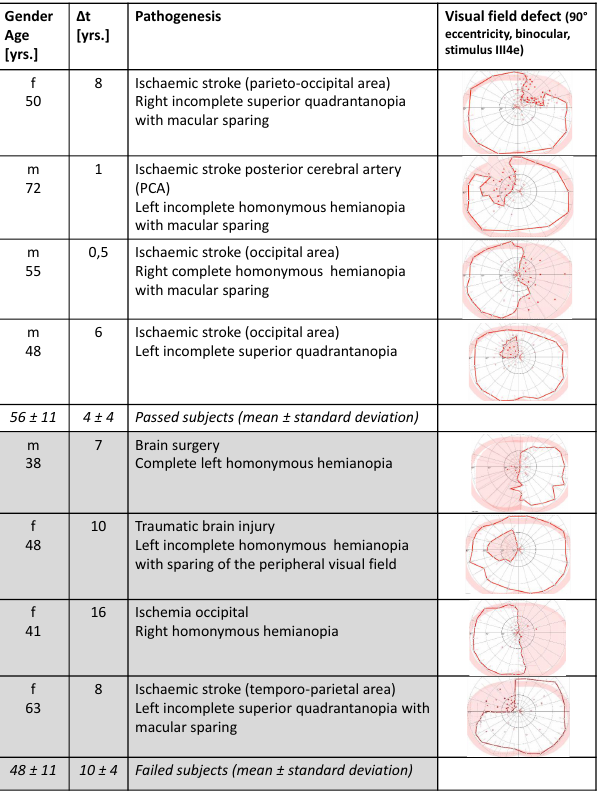
Figure 1 . Demographic data and binocular visual fields for the HVFD patients. ∆ t denotes the time since brain lesion. Patients who failed the driving fitness test are shaded in gray.